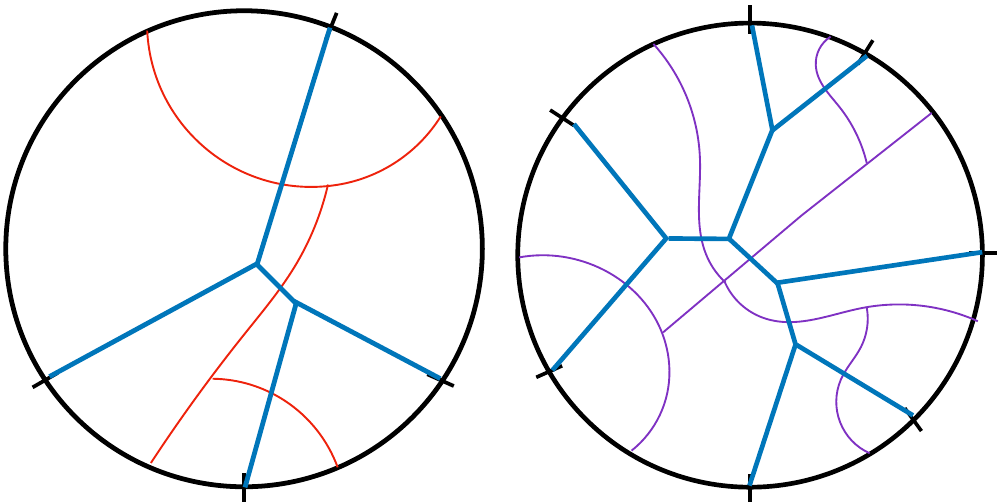
Figure 7 . Potentially minimal boundary configurations m 4 for 4 boundary regions and m 7 for 7 boundary regions. Both surfaces are constructed using the double bubble solution on H shown in each is an example of a hyperthread which could